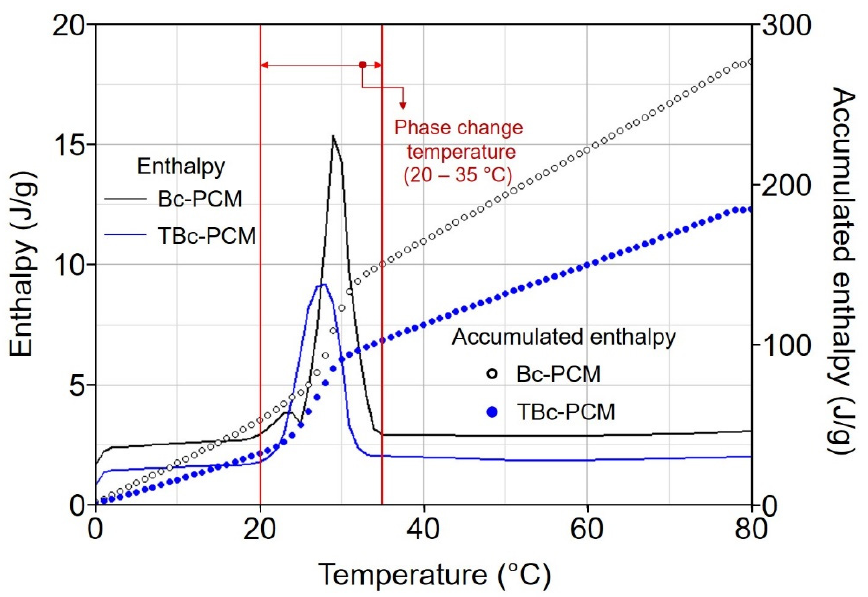
Figure 4. Enthalpy properties of Bc-PCM and TBc-PCM.